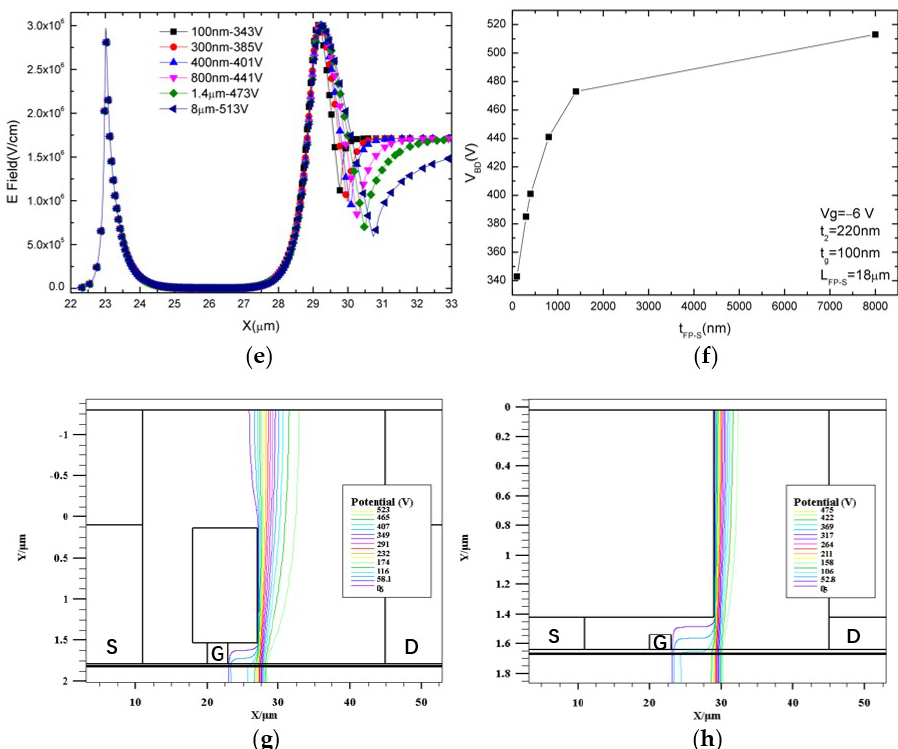
Figure 5. The electric field distributions along the channel for different values of ( a ) t 2 , ( c ) L FP-S , and ( e ) t FP-S . Off-state breakdown voltage V BD for different values of ( b ) t 2 , ( d ) L FP-S , and ( f ) t FP-S . The Potential line distributions along the channel when ( g ) t 1 = 250 nm, L FP-G = 4 µ m, t FP-G = 1.4 µ m, V BD = 521 V, and ( h ) t 2 = 120 nm, L FP-S = 18 µ m, t FP-S = 1.4 µ m, V BD = 473 V.